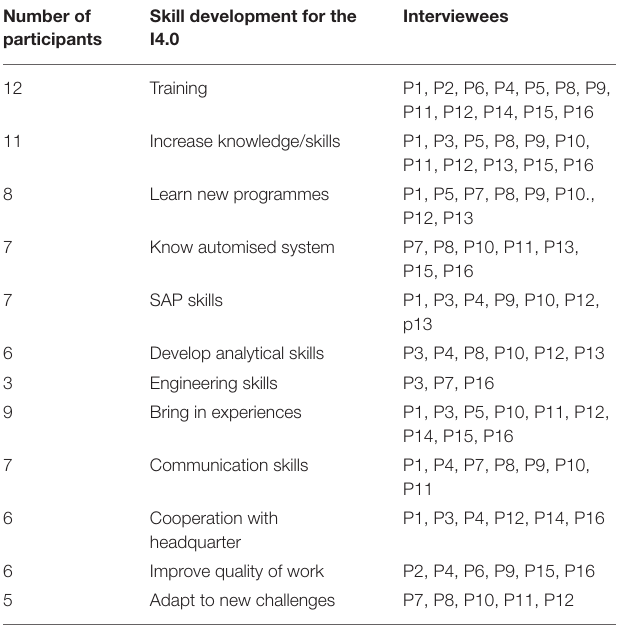
TABLE 3 | Skill development for sustainable practices. Number of Skill development for the participants I4.0